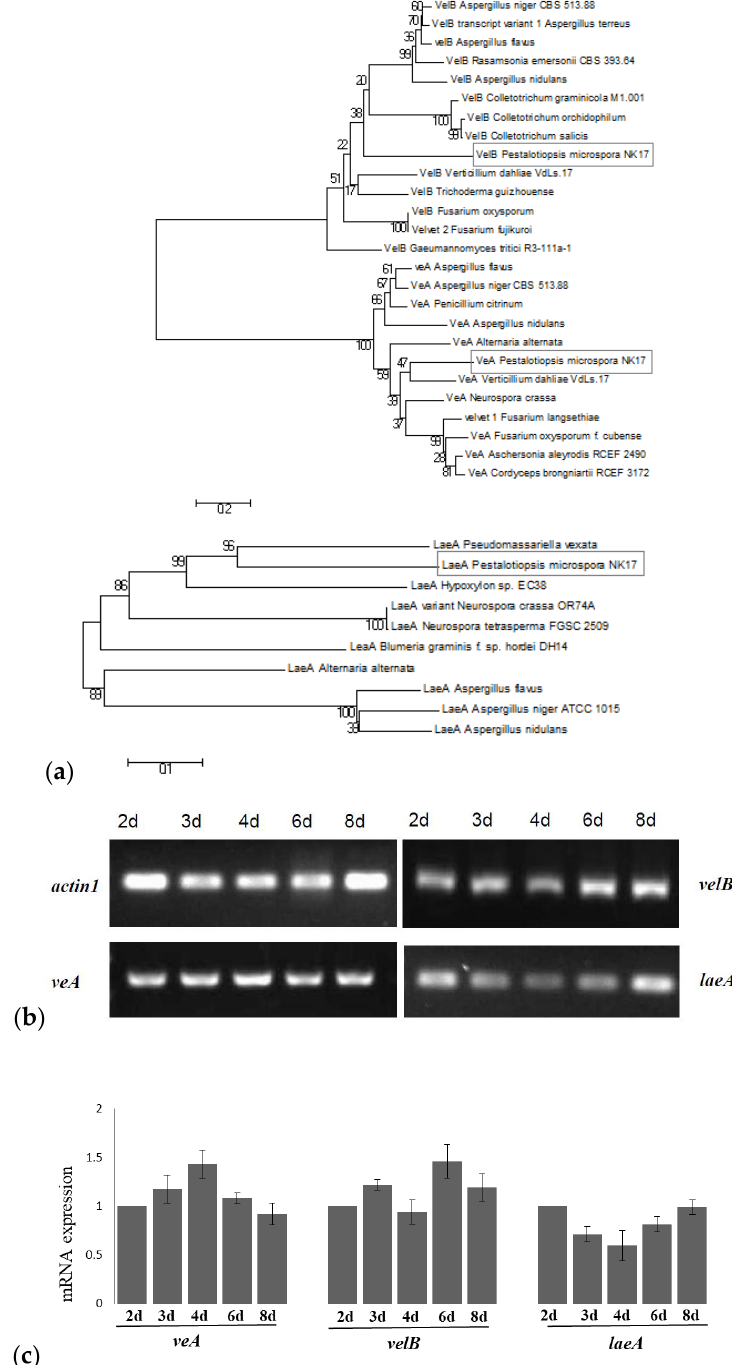
Figure 1. ( a ) Phylogenetic tree of fungal VeA, VelB, and LaeA proteins built by molecular evolutionary genetics analysis (MEGA) 5.1 software. Indicated by the grey rectangles are VeA, VelB and LaeA from Pestalotiopsis microspora . Phylogenetic relationships were inferred using the Neighbor-Joining method and bootstrap tested (1000 replicates). Branch lengths of the tree are drawn to scale and bootstrap support indicating at the branch sites. ( b ) Reverse transcription polymerase chain reaction (RT-PCR) for the mRNA of veA , velB , and laeA to show their expression. The top left panel was the messenger RNA (mRNA) of the actin-encoding gene act1 used as the control in this study. ( c ) Expression levels by RT-PCR were estimated by densitometry and normalized to actin levels. Three experiments were done in each case. Error bars indicate standard